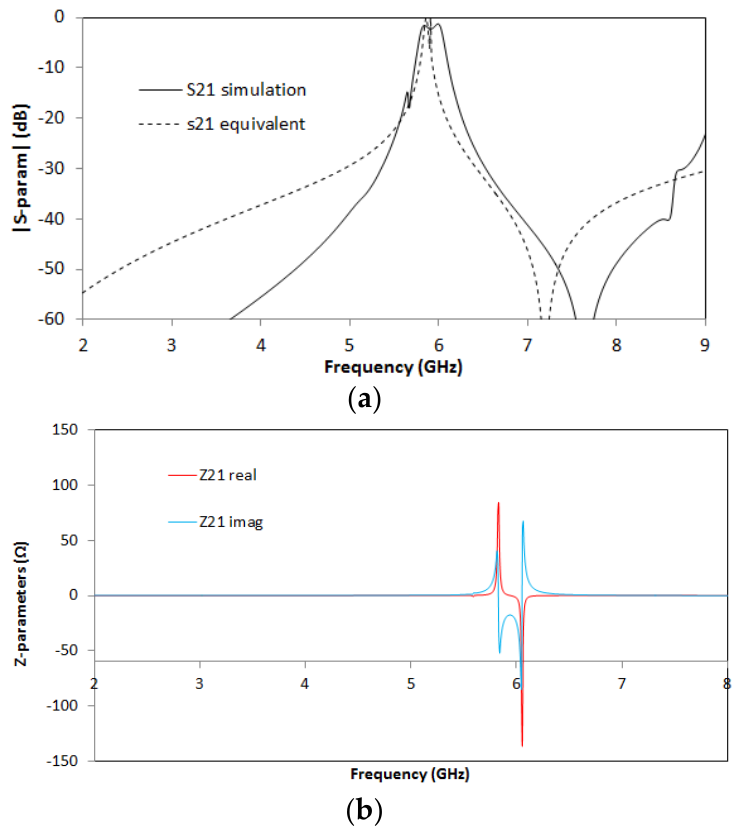
Figure 27. ( a ) Simulated S21 (solid black line), simulated S21 for the equivalent circuit model (dashed black line). ( b ) Impedance graph: Z21 real part (solid red line), Z21 imaginary part (solid blue line).